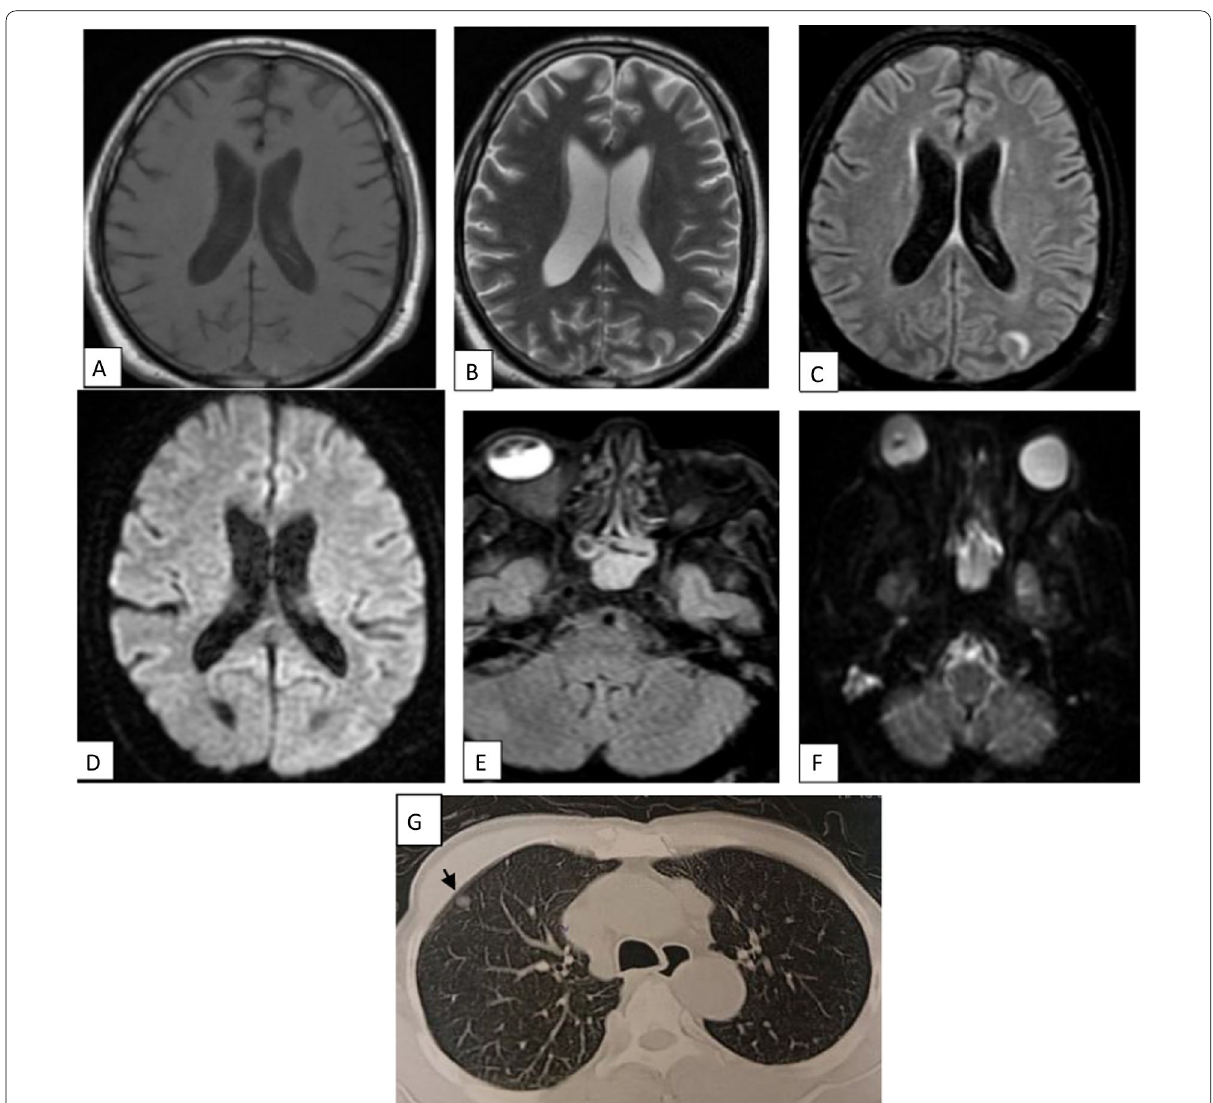
Fig. 6 A 47-year-old male patient presented with post COVID ophthalmoplegia in six cardinal directions, MRI a axial T1WI, b axial T2& c axial FLAIR d DWI show left occipital gyral edema with no diffusion restriction. In addition to ethmoidal sinusitis which show restricted diffusion in DWI ( e ) and of high FLAIR SI ( f ), histopathologically proved to be invasive fungal sinusitis. CT chest showed pulmonary nodule (short black arrow) probably post COVID infection sequel